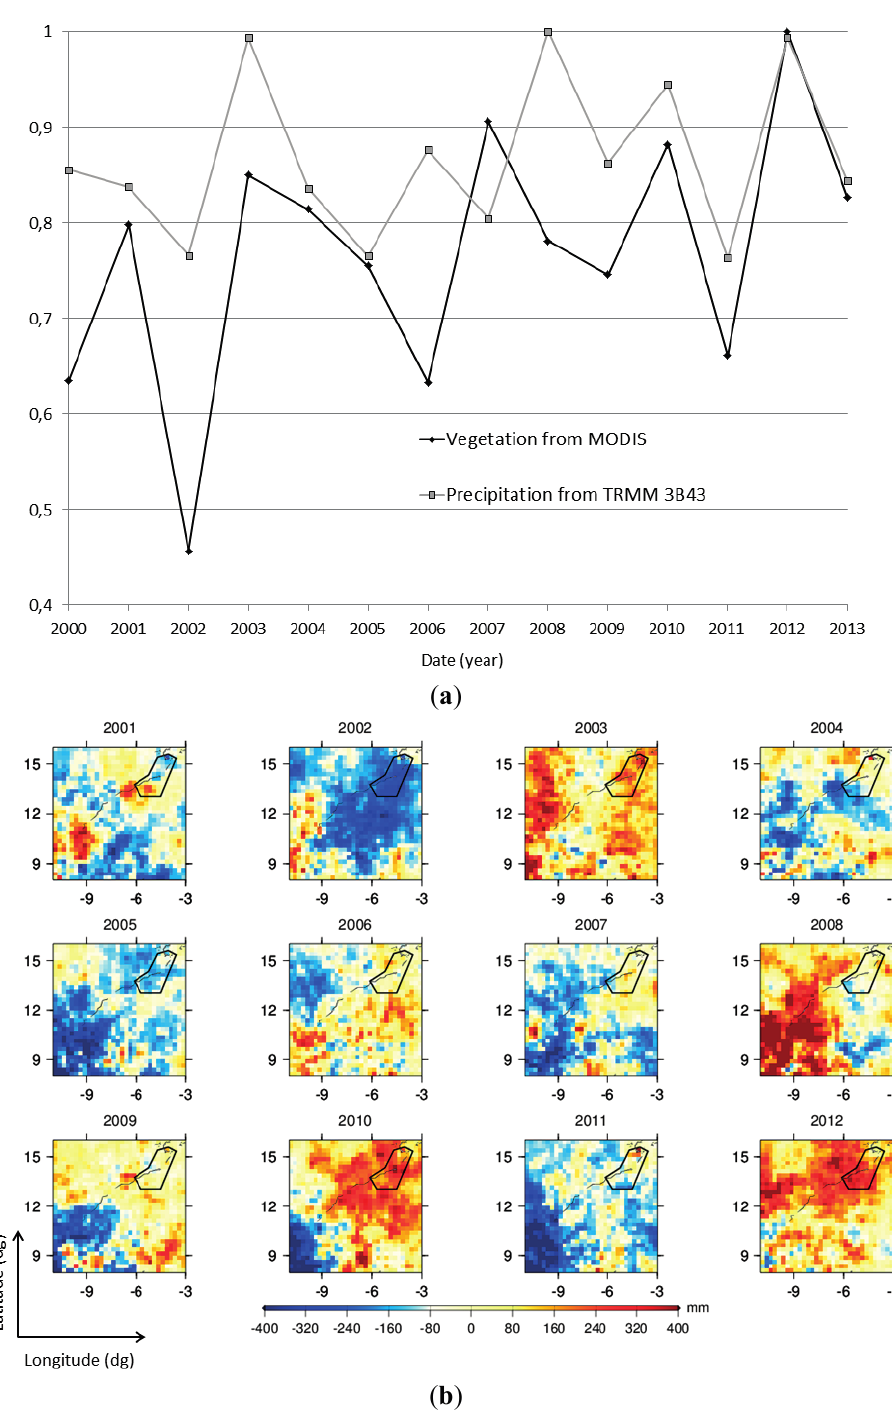
Figure 12. ( a ) Annual normalized precipitation over the Region Of Interest (ROI) from Tropical Rainfall Measuring Mission 3B43 compared to annual normalized coverage area of vegetation over the Inner Niger Delta (IND) measured by Moderate Resolution Imaging Spectroradiometer; ( b ) annual rainfall anomalies with respect to the global